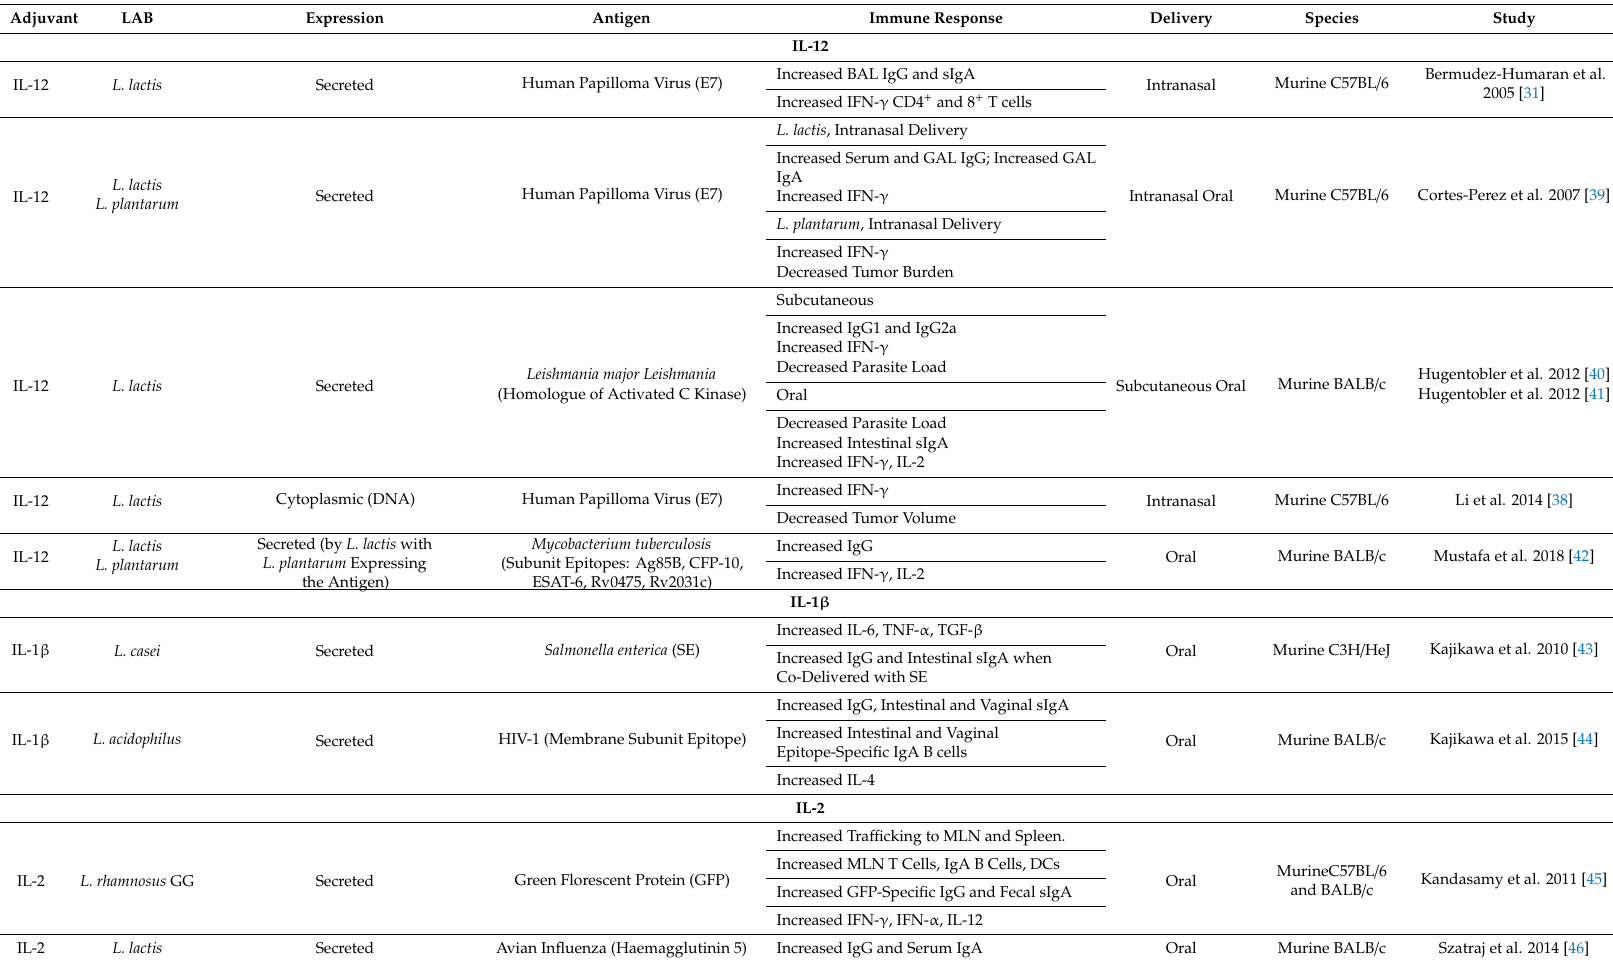
Table 1. Cytokine adjuvant strategies for lactic acid